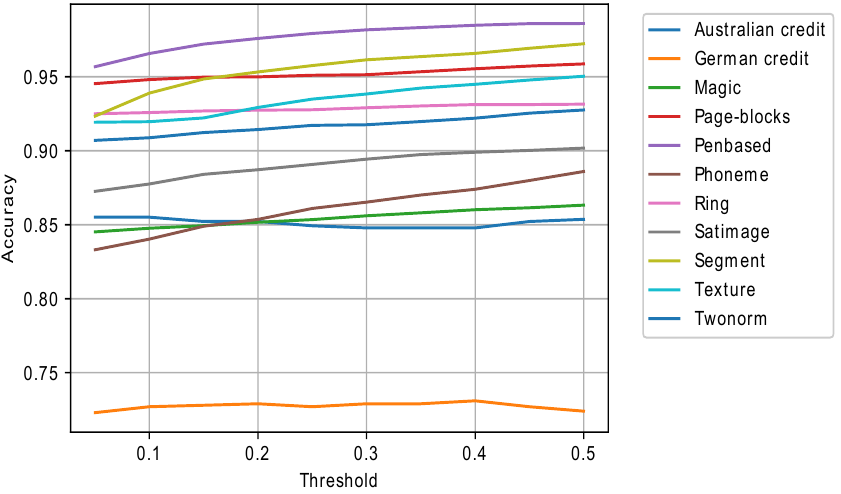
Figure 7. CBV accuracy dependence on the threshold value, random forest as assisting classifier.